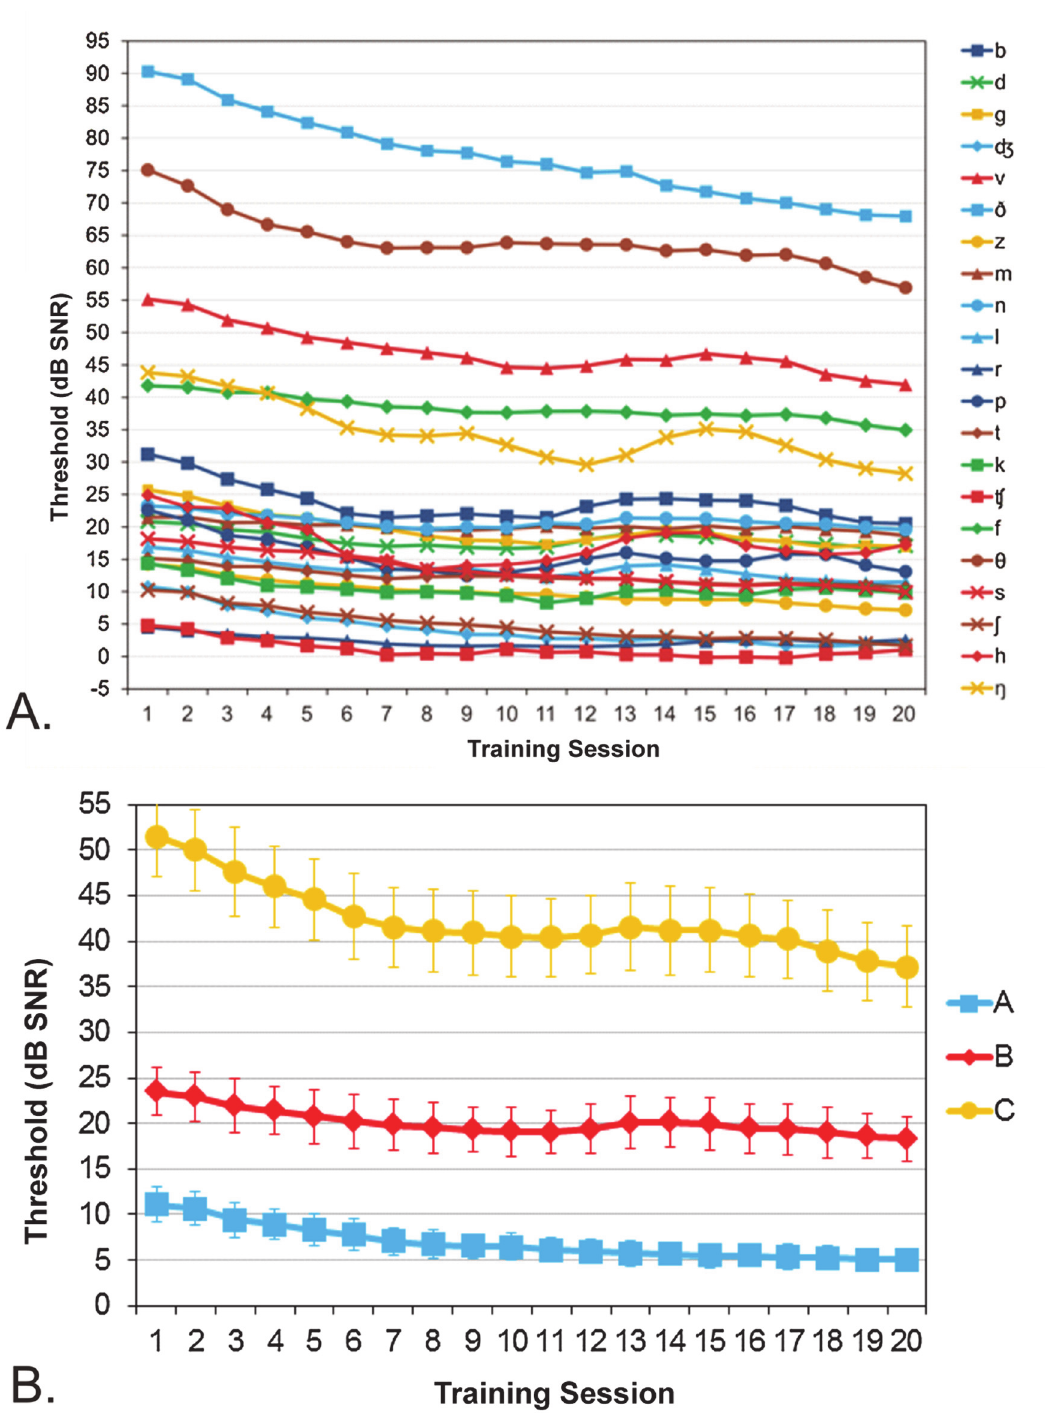
Fig 3. Mean consonant thresholds across training session. Top: individual consonants. Bottom: changes in mean consonant thresholds for consonant Groups A, B, and C during training. Error bars show standard errors that reflect inter-listener differences in threshold.